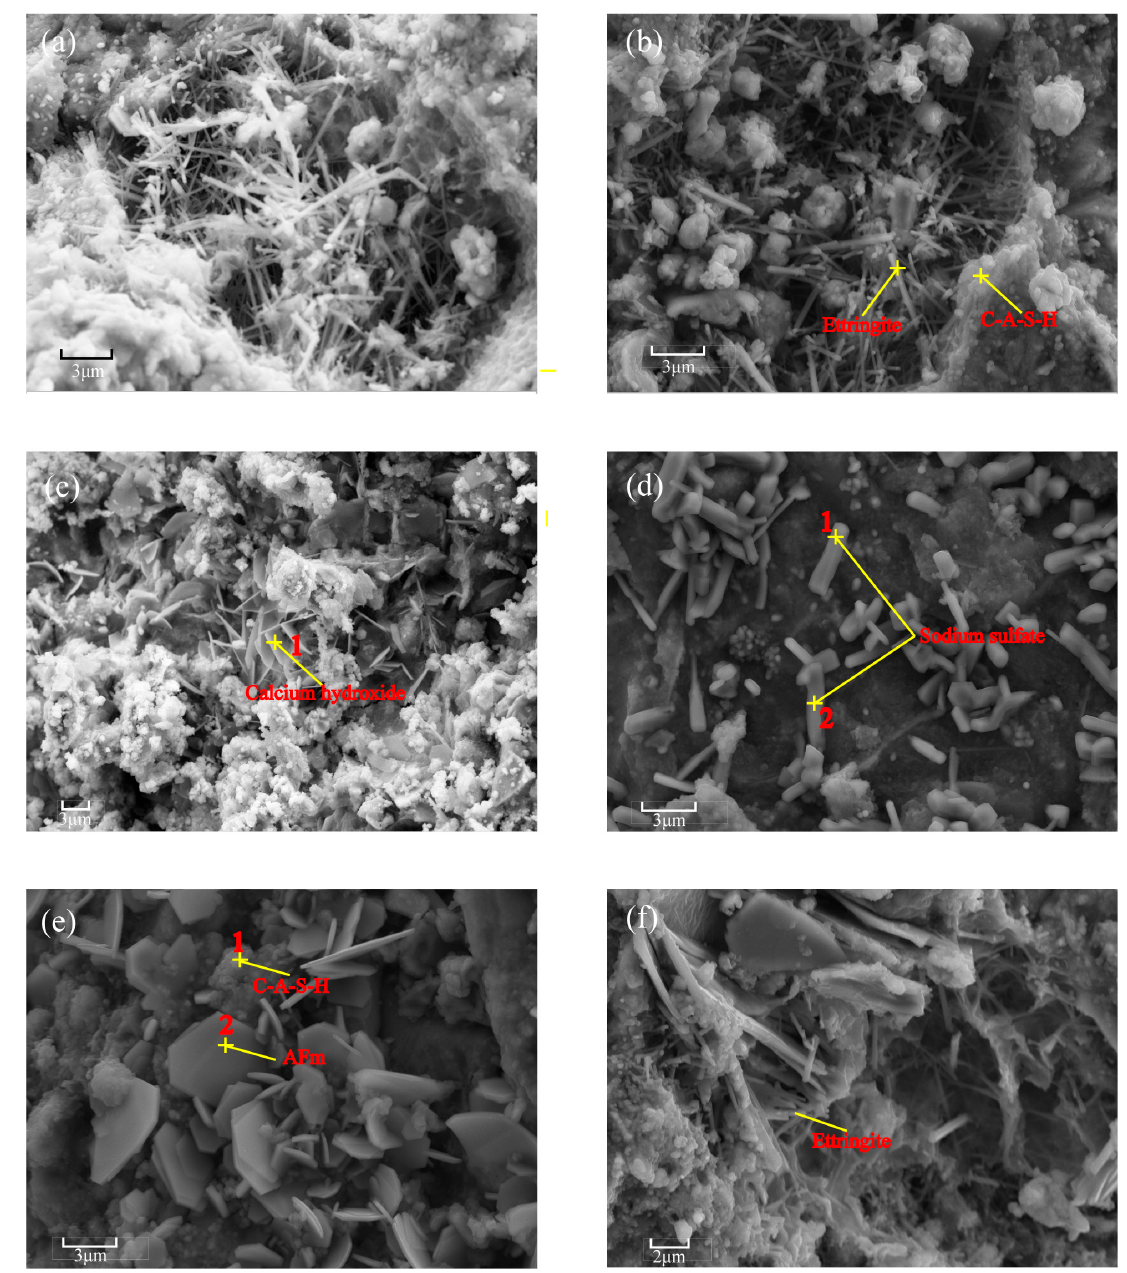
Figure 5. SEM-EDS result for ( a ) B-C3-3 d; ( b ) B-C3-28 d; ( c ) B-C3(V)-3 d; ( d ) B-C3(V)-28 d; ( e ) B-C3(III)-3 d; ( f ) B-C3(III)-28 d.